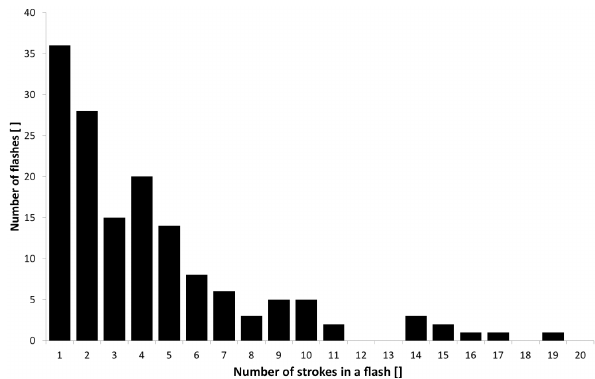
peak current greater than 10 kA were detected (DE = 100 %).